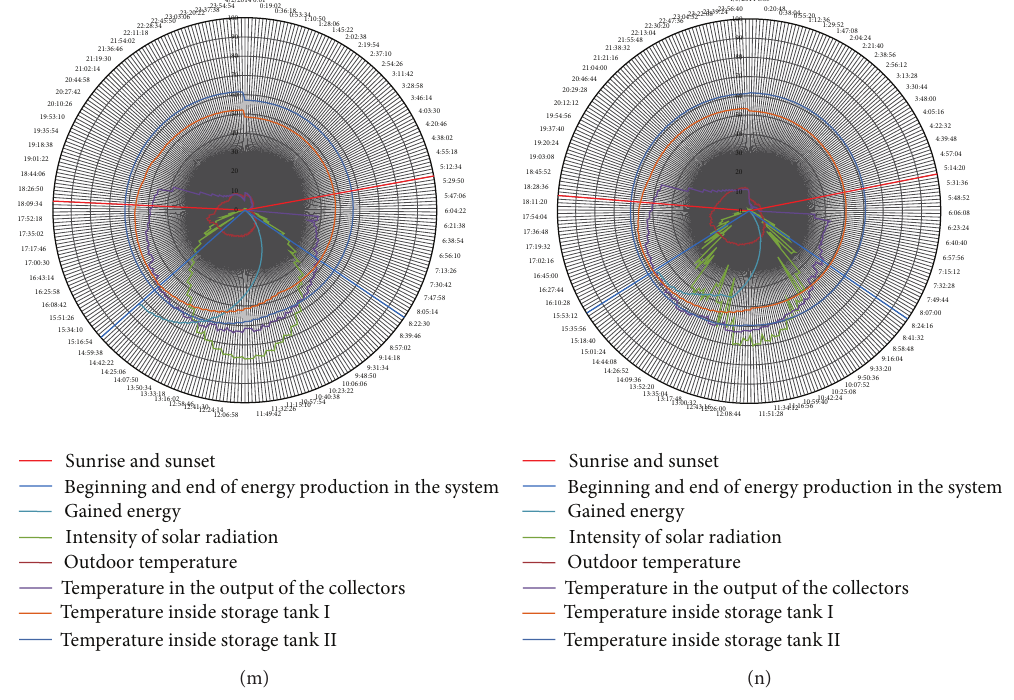
Figure 17: Graphs showing the courses of the monitored values of both the static system ((a)–(g)) and the system with rotation ((h)–(n)).